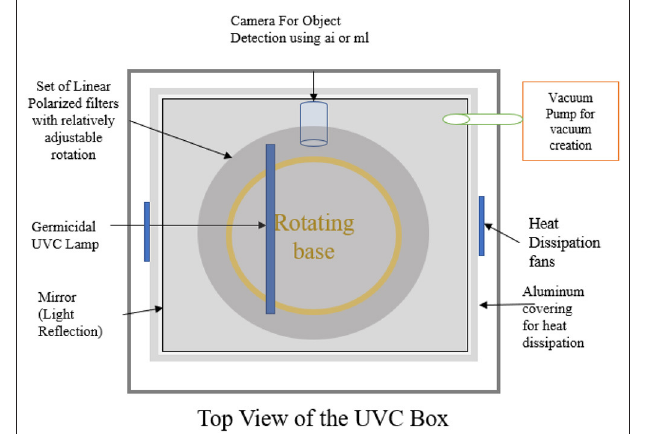
on the rotating base. It also prevents the direct penetration of the UVC. The base starts rotating with the start of the sanitization